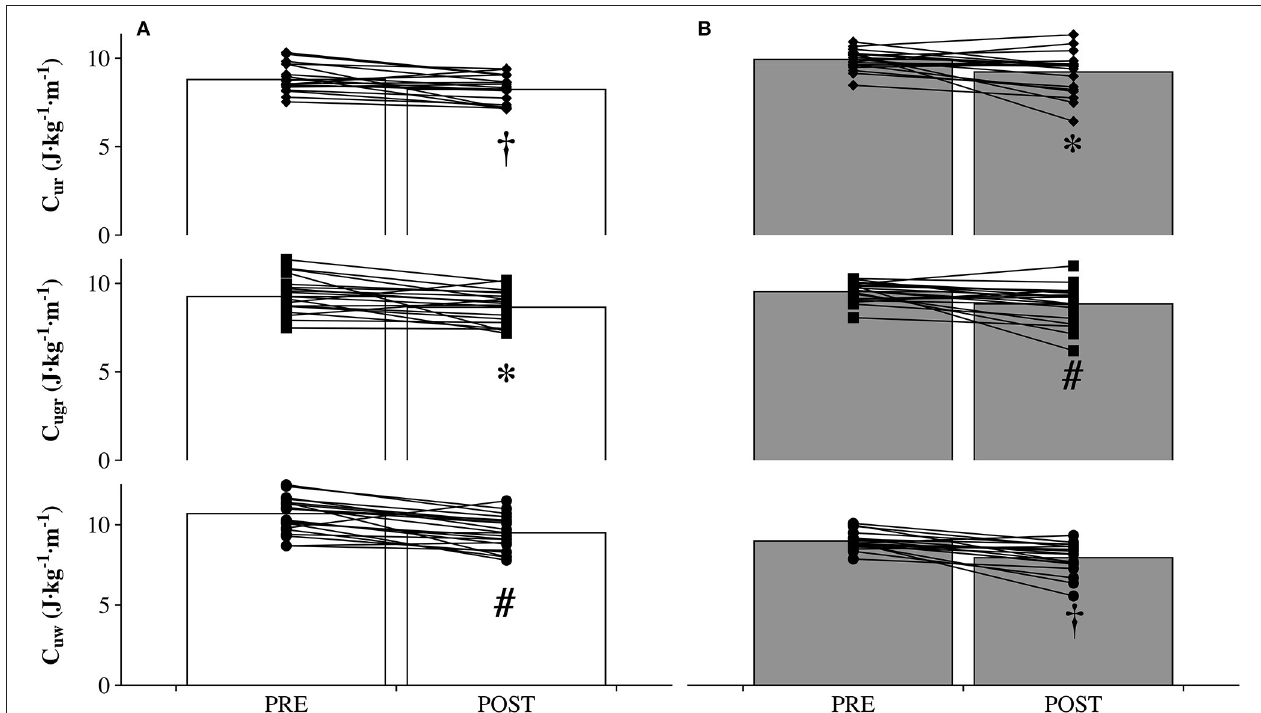
FIGURE 1 | Differences in gross (A) , and net (B) energy cost before (PRE) and after (POST) the MUM ( n = 19). * P < 0.05, # P < 0.01; † P < 0.001. C uw : Walking at 5km · h − 1 and + 20%. C ugr : Grounded running at 6km · h − 1 and + 15%. C ur : Running at 8km · h − 1 and +